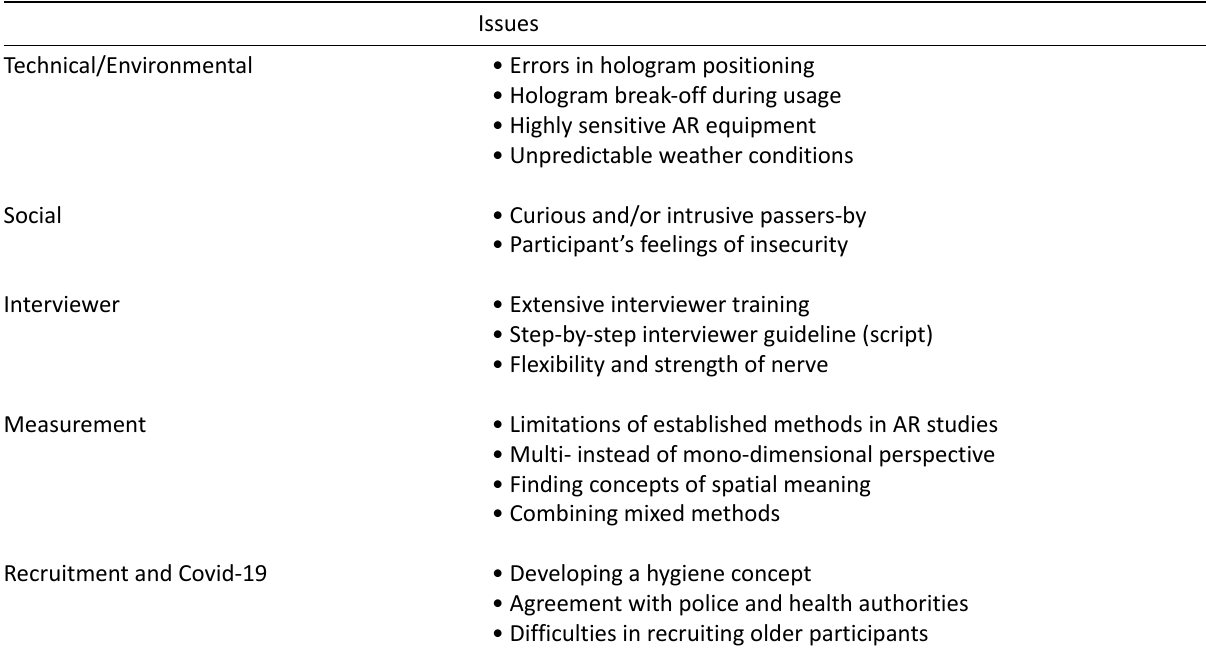
Table 1. Overview of methodological issues when capturing augmented